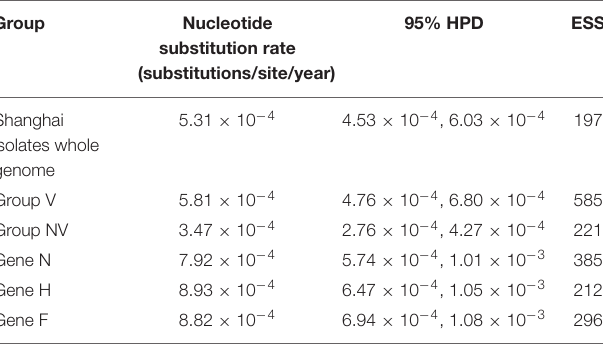
TABLE 2 | Nucleotide substitution rates of MV isolates and individual genes in Shanghai. Group